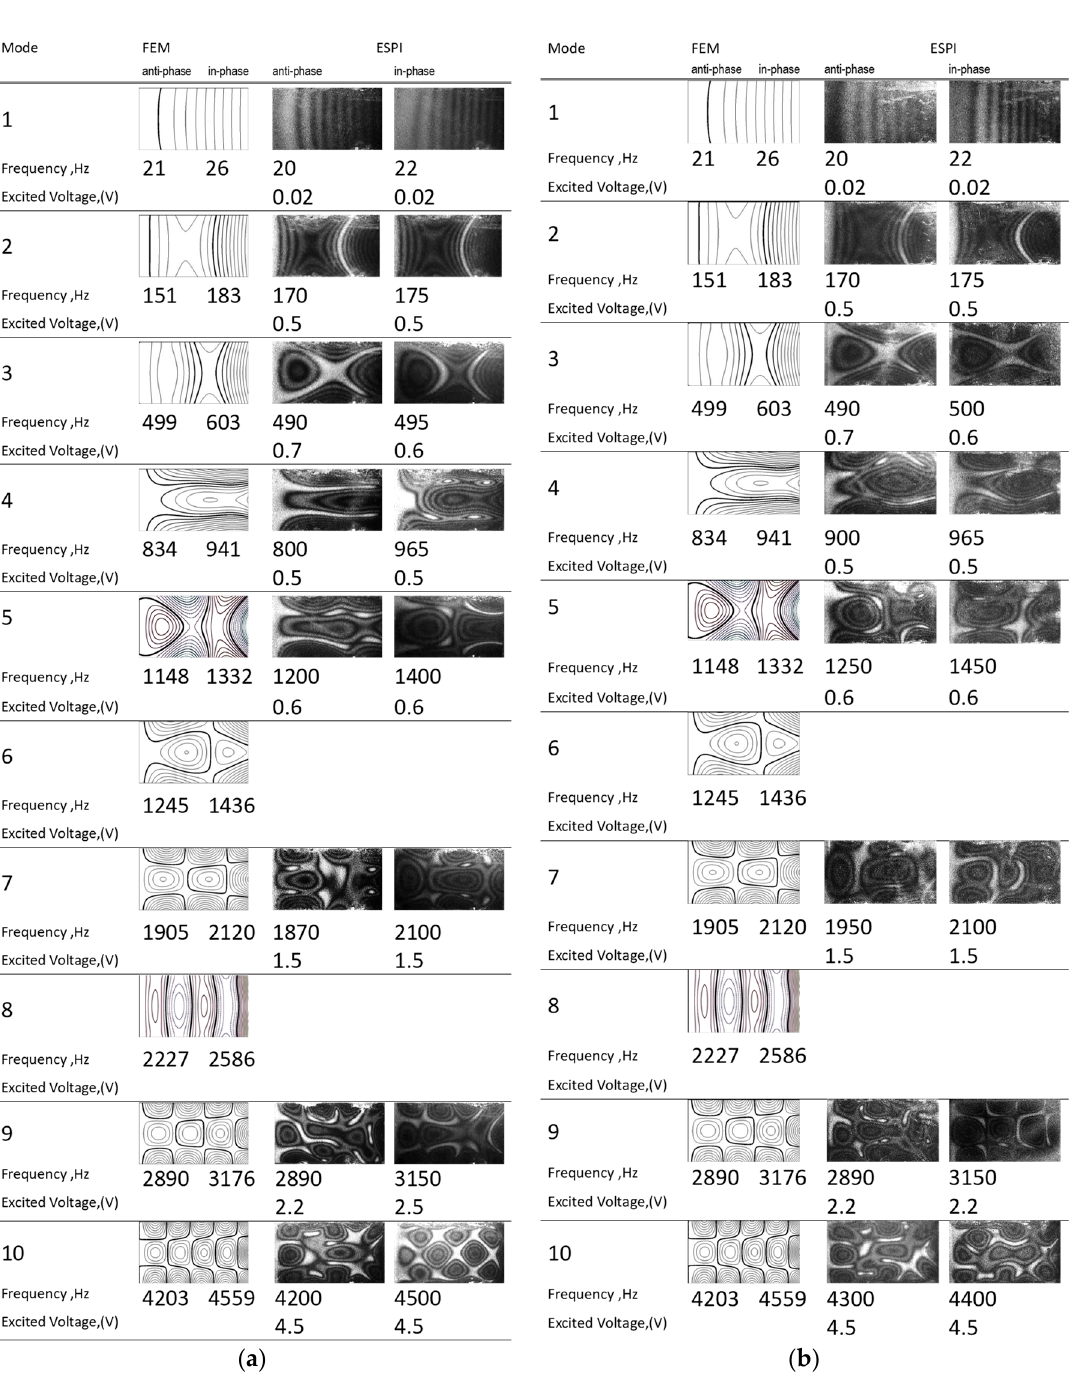
Figure 9. AF-ESPI and FEM results obtained from pumping element coupled with water in the ( a ) upper and ( b ) lower piezoelectric plates.